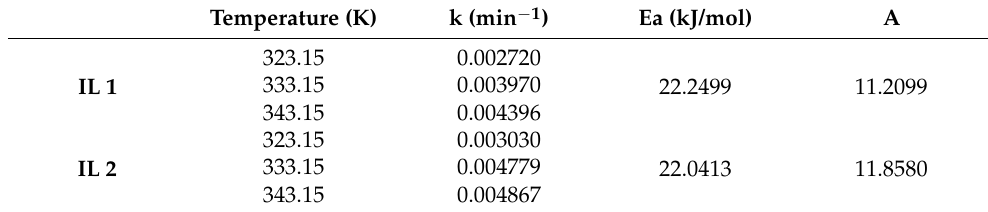
Table 2. Kinetic parameters of DT reaction for